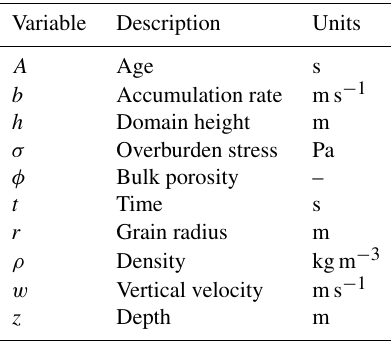
Table 2. Physical